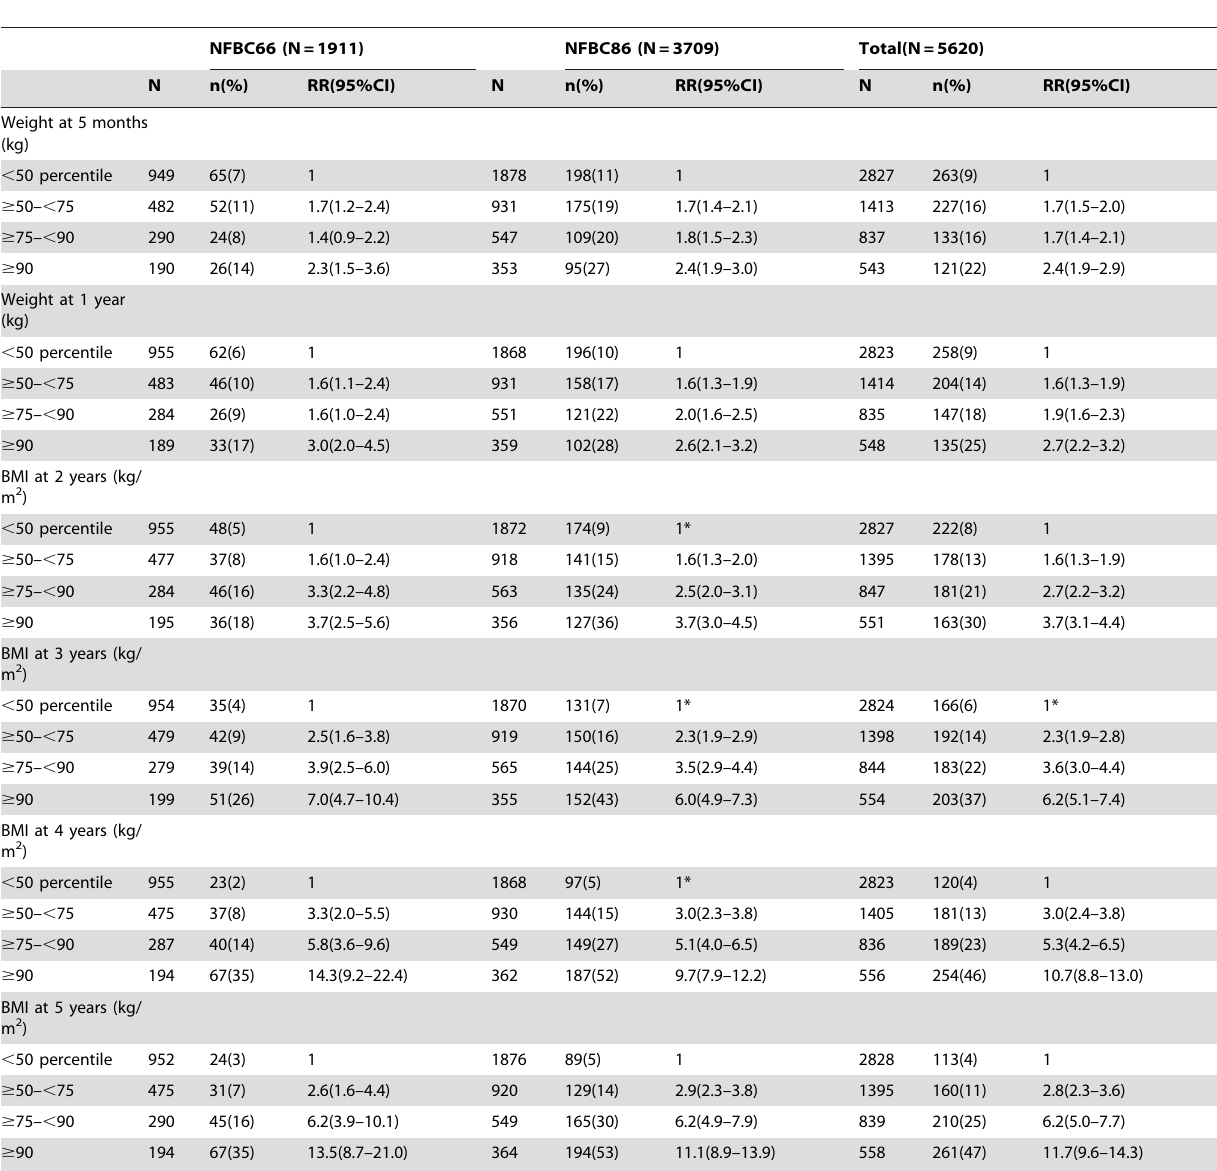
Table 3. Relative risk of overweight at the age of 15 years according to the IOTF associated with early weight and BMI measures in the NFBC1966 and the